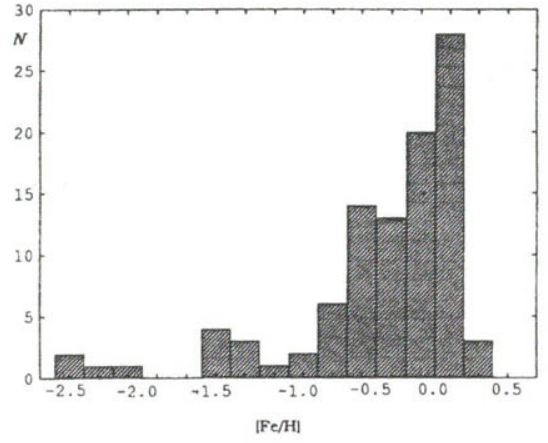
Fig. 3. Distribution of the sample stars by [Fe/H]. The bin size is 0.2